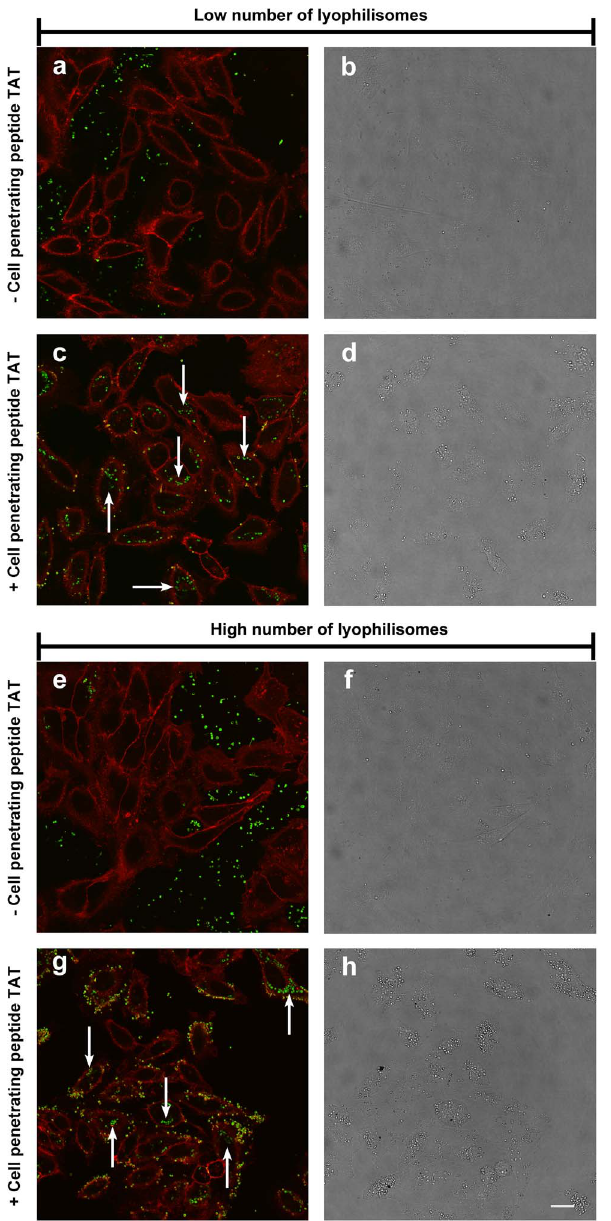
Figure 6. Internalization of lyophilisomes without and with TAT peptide by HeLa cells. Lyophilisomes without and with TAT peptide were administered to 30,000 HeLa cells using two dosages (0.8 million/500 m l (a-d) and 3.5 million/500 m l (e-h). Cells incubated with lyophilisomes without TAT peptide had internalized few lyophilisomes (a/e), whereas TAT-conjugated lyophilisomes showed high cellular uptake for almost all cells (c/g). Green fluorescence corresponds to lyophilisomes and red fluorescence (CellMask orange) visualizes the plasma membrane. Bright field images (b/d/f/h) show normal morphology of the cells. Scale bar represents 20 m m. TAT = trans- activating transcriptional activator.